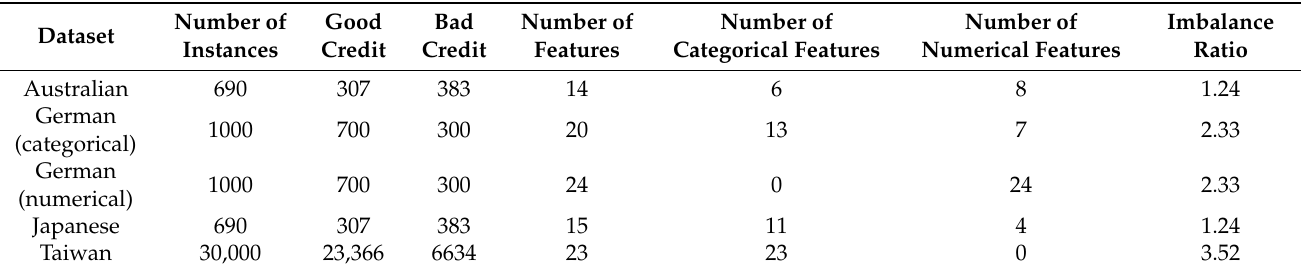
Table 1. Characteristics of the five credit